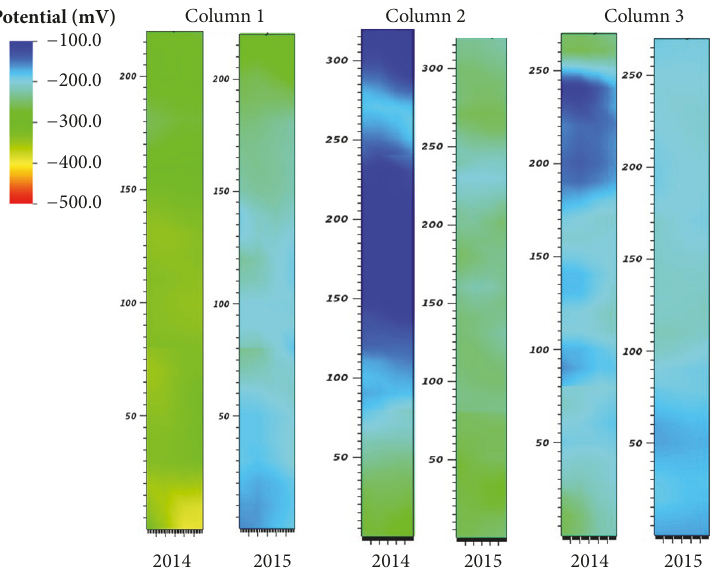
Figure 12: The potential distribution on each column of Object II for 2014 and 2015.